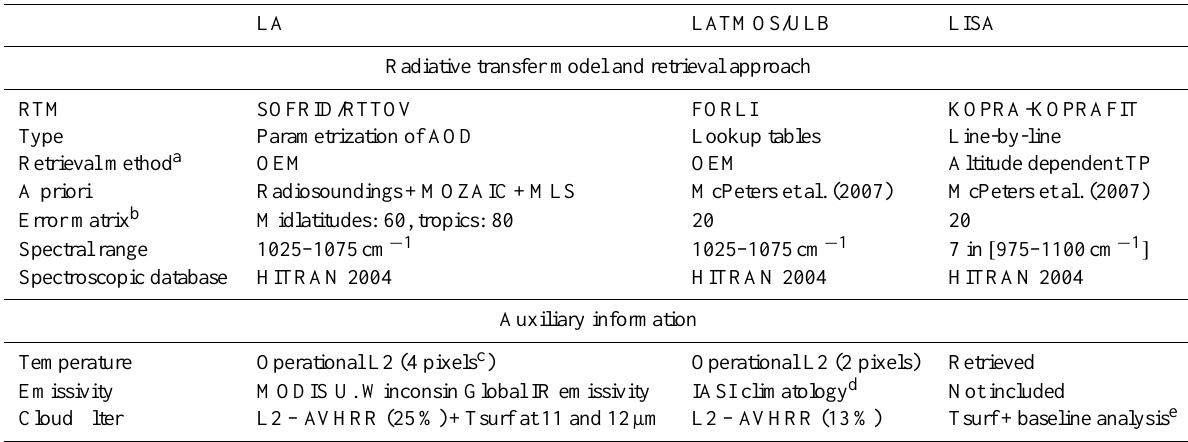
Table 1. Summary of the retrieval properties of the three